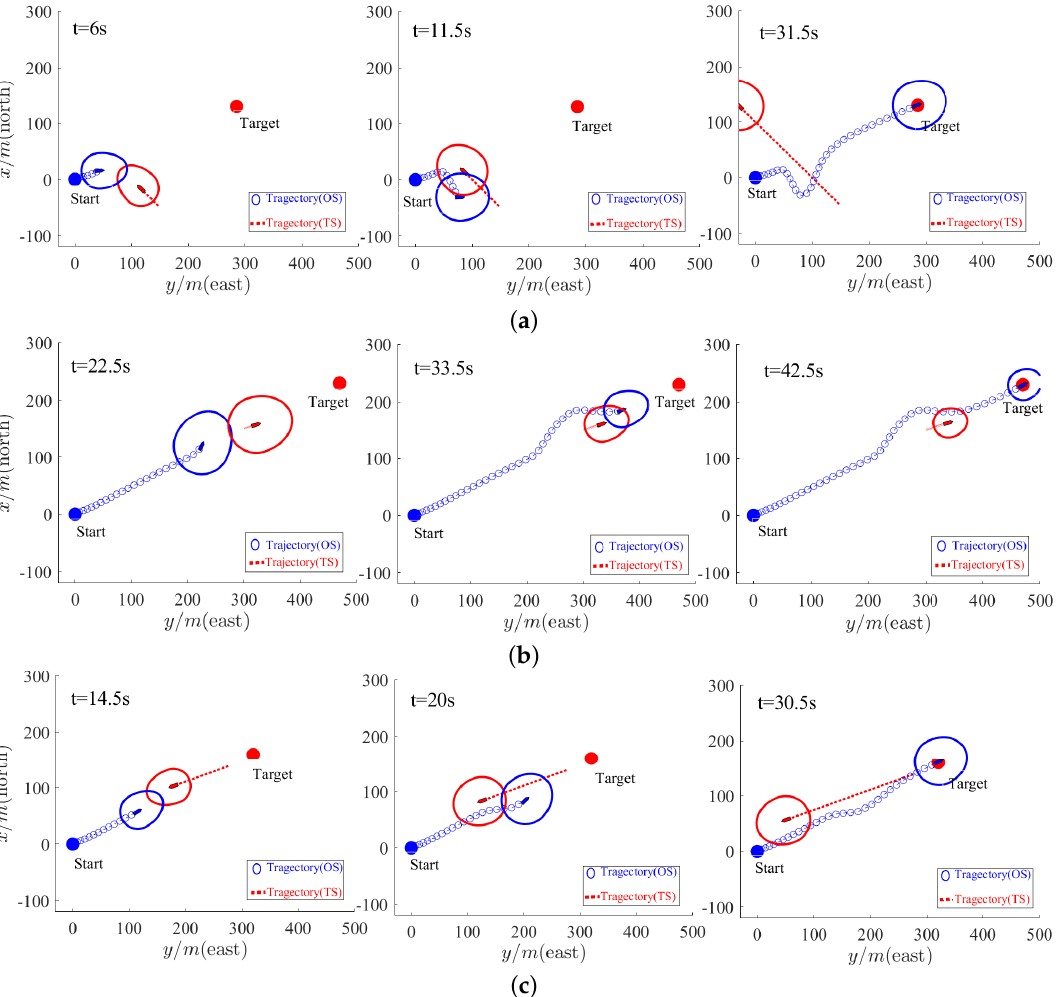
Figure 10. Simulation results of a single TS representing different encounter situations in COLREGs: ( a ) crossing; ( b ) over- taking; ( c ) head −